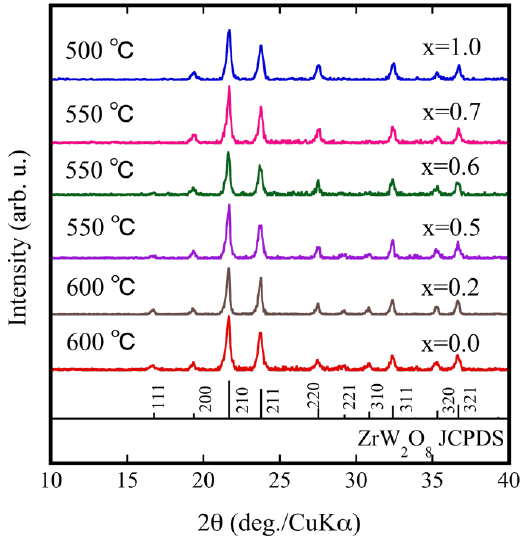
Figure 3. XRD patterns of ZrW 2 − x Mo x O 8 sintered bodies. Table 1. Measurement density and relative densities of ZrW 2 − x Mo x O 8 sintered bodies.